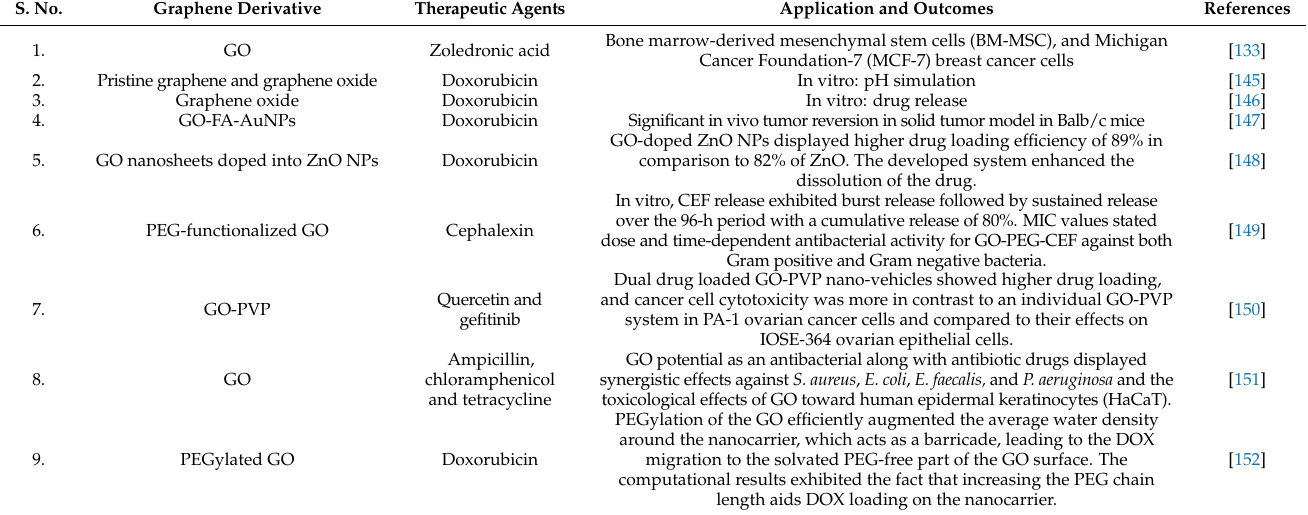
Table 4. Application of graphene derivatives for drug